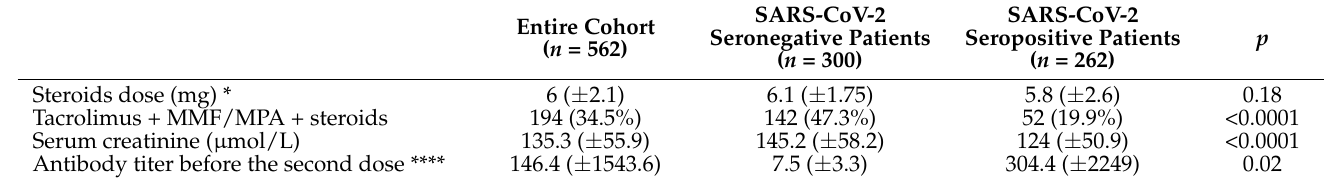
Data are expressed as means (±standard deviations) or counts (percentages), as appropriate. Abbre-